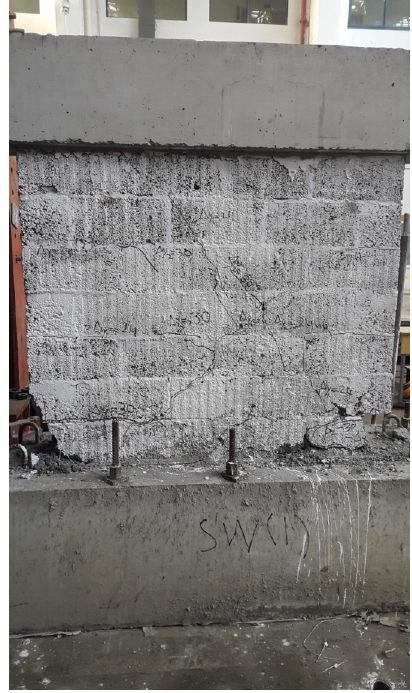
Figure 11. End ‐ of ‐ test picture of entire specimen SW1. Figure 11. End-of-test picture of entire specimen